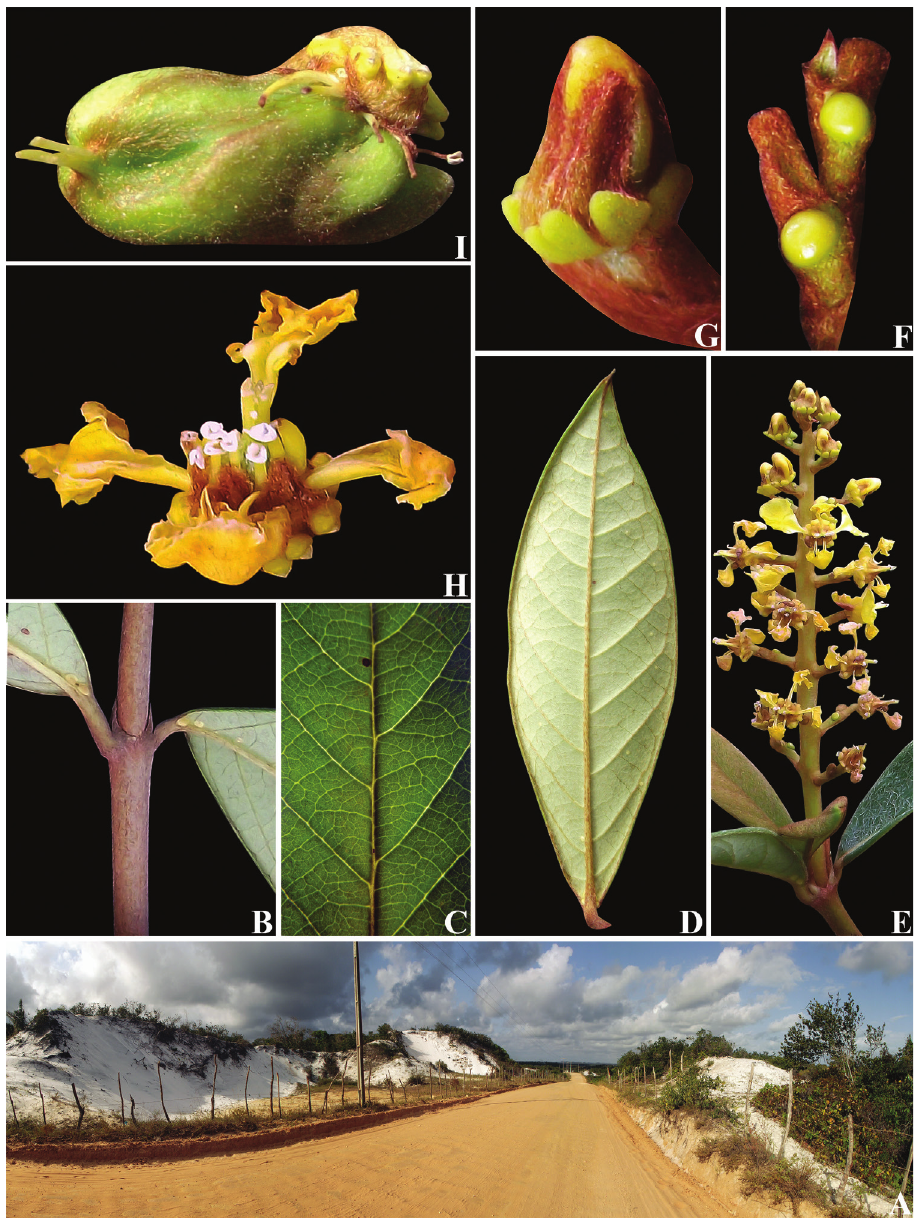
Figure 9. Mcvaughia sergipana . A sandy dune where M. sergipana occurs B detail of epipetiolar stipules C detail of leaf venation patterns D abaxial surface of a leaf E inflorescence showing buds and flowers F detail of glandular bracts G floral bud H flower in frontal view I fruit in side view. Photos by R.F.